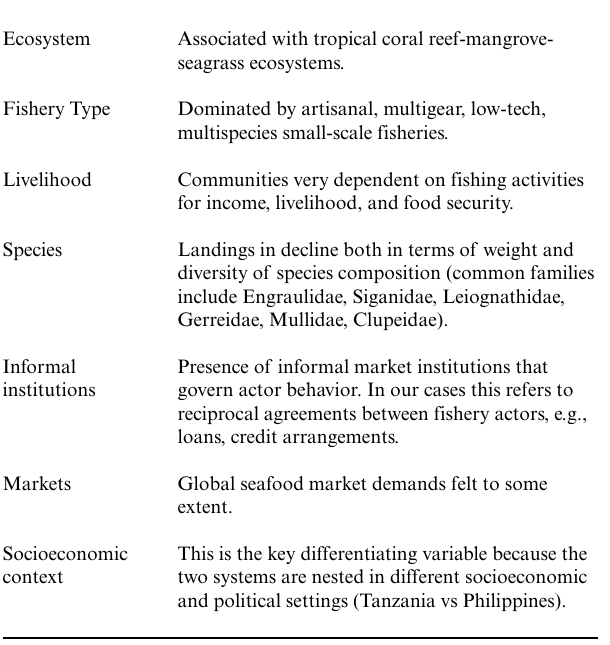
Table 1 . Key system dimensions controlled for in comparison across sites. Both cases, Concepcion and Unguja, are similar across all the stated dimensions thus allowing us to approximate a “most similar” design of cross-case comparison. The main attribute that differs across sites is the socio-political setting that is defined by the fact that we are studying fisheries in two different countries in South East Asia and East